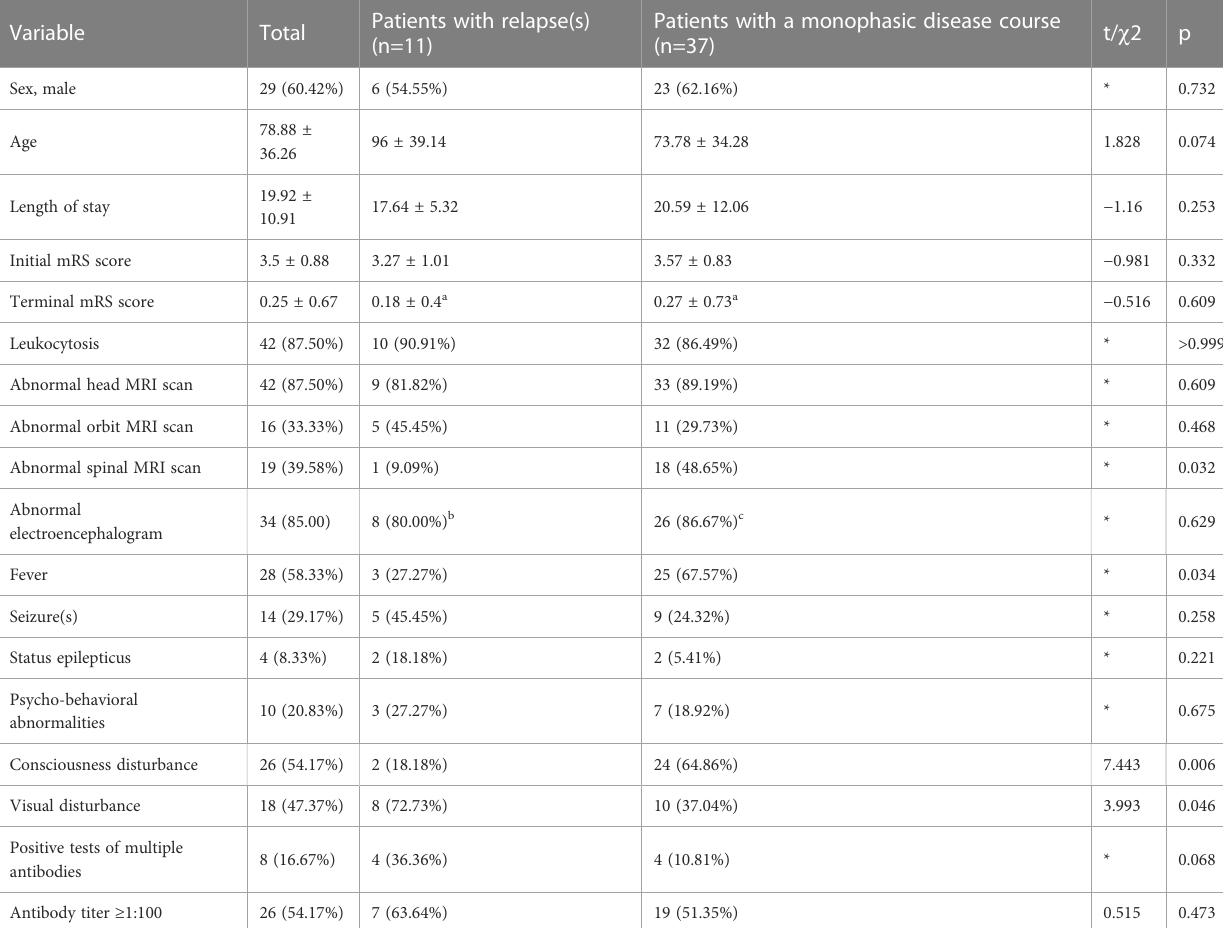
TABLE 3 Comparison between MOG-AD patients with relapses and such patients with a monophasic disease course.